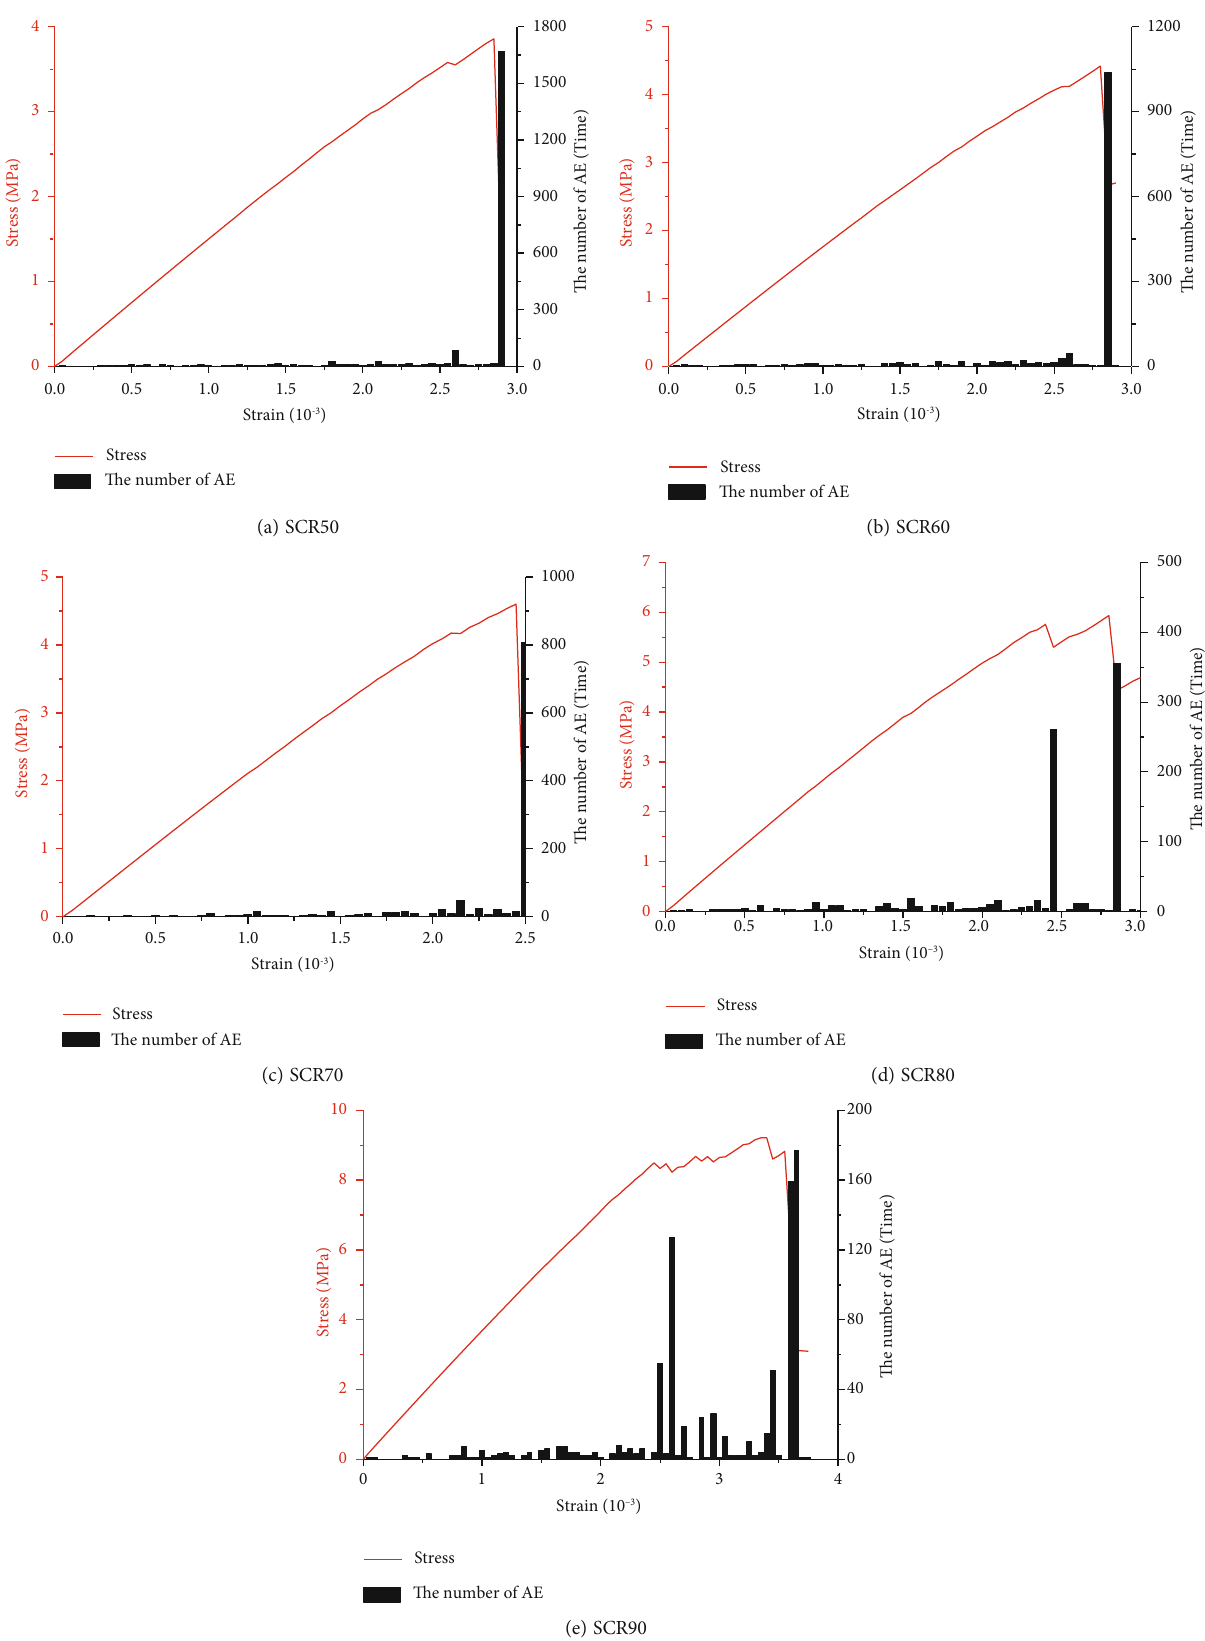
Figure 11: AE curves of samples pressurized with